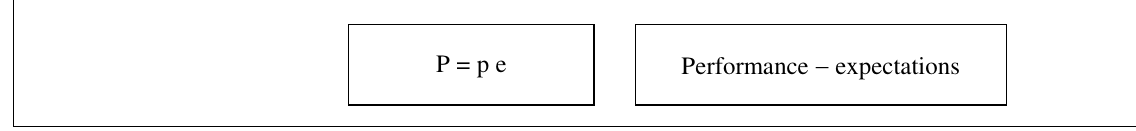
Fig. 1. The customer satisfaction equation